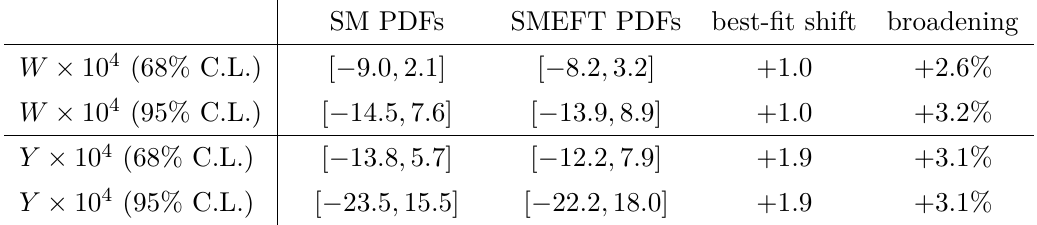
Table 1 . The 68% and 95% C.L. bounds on the W and Y parameters obtained either for a fit in which PDFs are kept fixed (SM PDFs) or in a fit in which PDFs are fitted simultaneously with either W or Y (SMEFT PDFs). The fourth and fifth column indicate the absolute shift in best-fit values, eq. (4.3), and the percentage broadening of the SMEFT bounds, eq. (4.4), when the PDFs are allowed to change alongside the Wilson